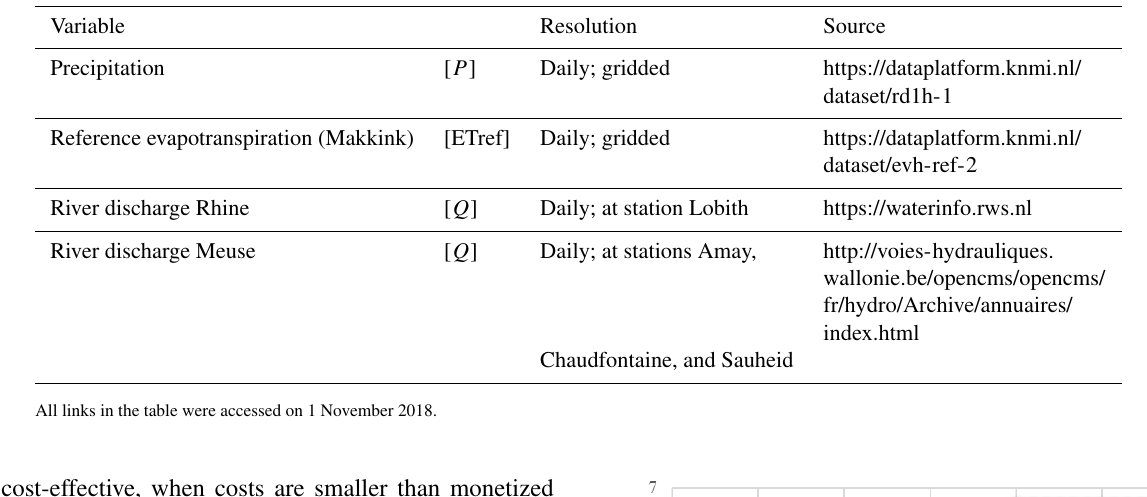
Table 2. Overview of measurement data sources used as model input.